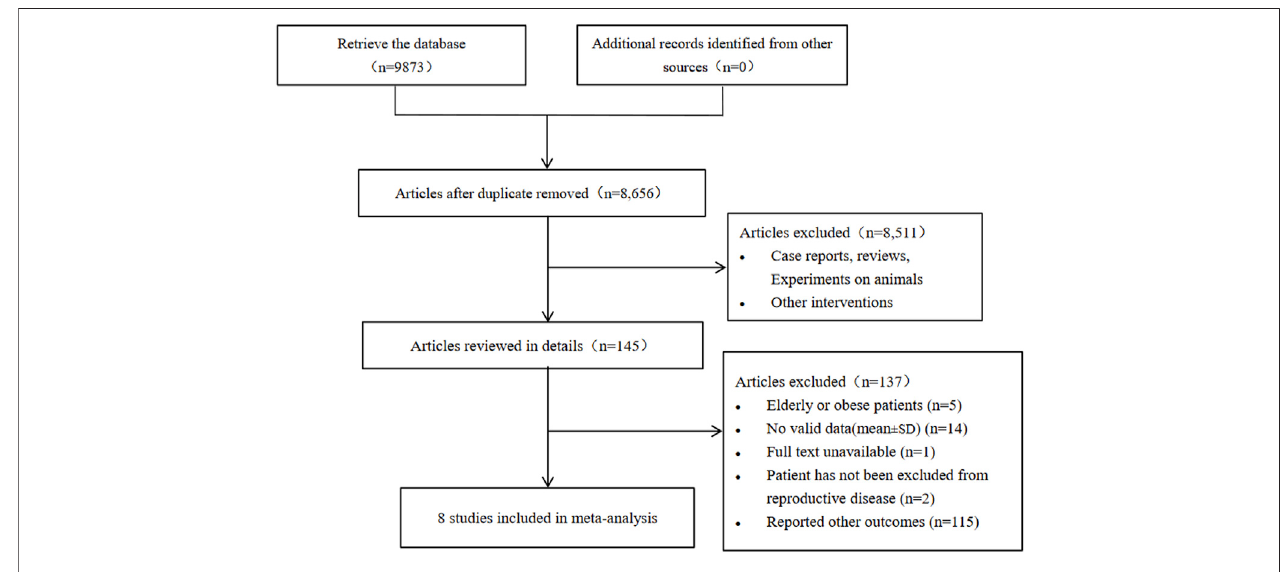
FIGURE 1 | Flowchart of study